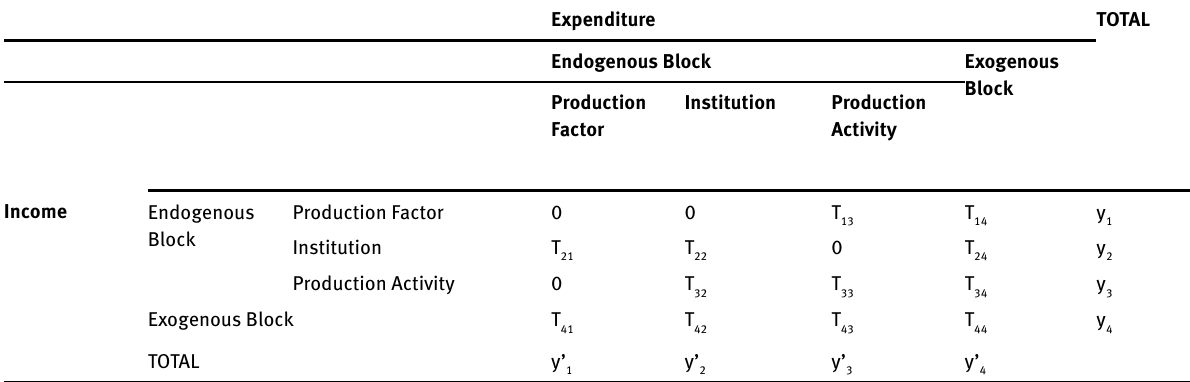
Table 1: Basic Framework of Indonesia’s SNSE